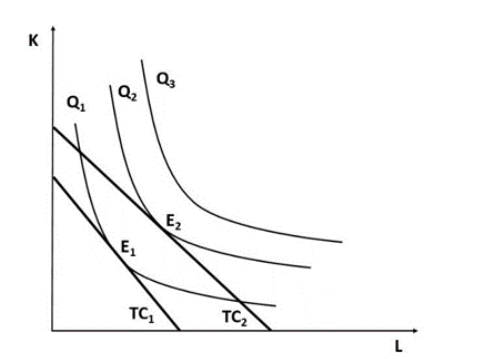
Figure 2: Optimal combination of inputs K and L of the production function Q. [36]